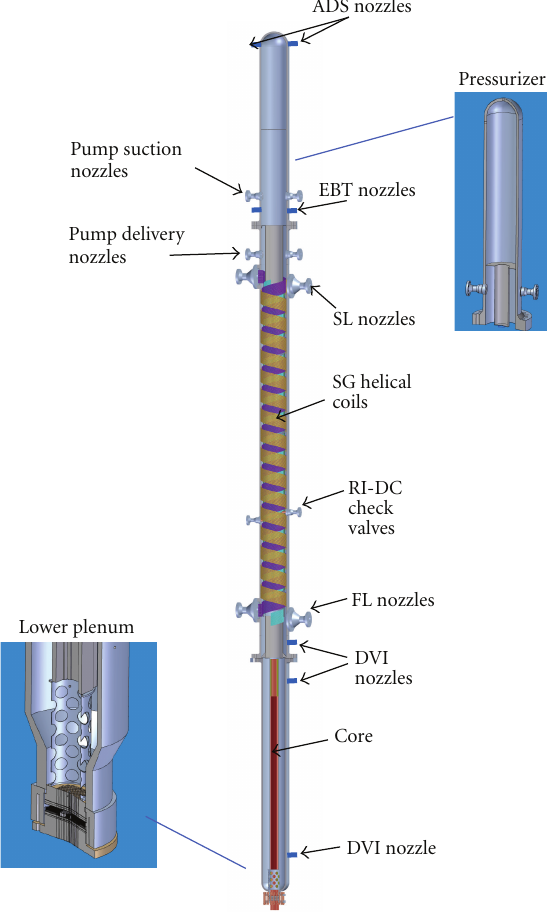
Figure 5: SPES3 reactor pressure